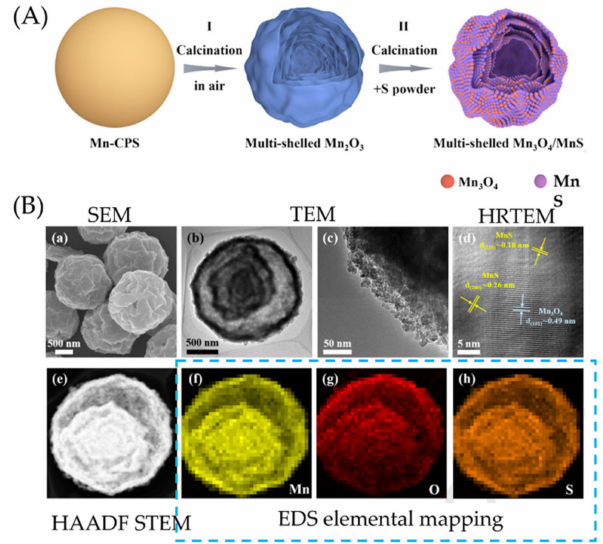
Figure 27. ( A ) Schematic illustration for the fabrication of Mn 3 O 4 /MnS and ( B ) (a) SEM image, (b,c) TEM image and (d) HRTEM image of Mn3O4/MnS heterostructures building multi-shelled hollow microspheres; (e–h) HAADF STEM and EDS elemental mappings of different elements of Mn, O and S recorded from a single heterogeneous Mn3O4/MnS multi-shelled hollow sphere. Reproduced with permission from reference [113]. Copyright 2022, Elsevier Ltd.